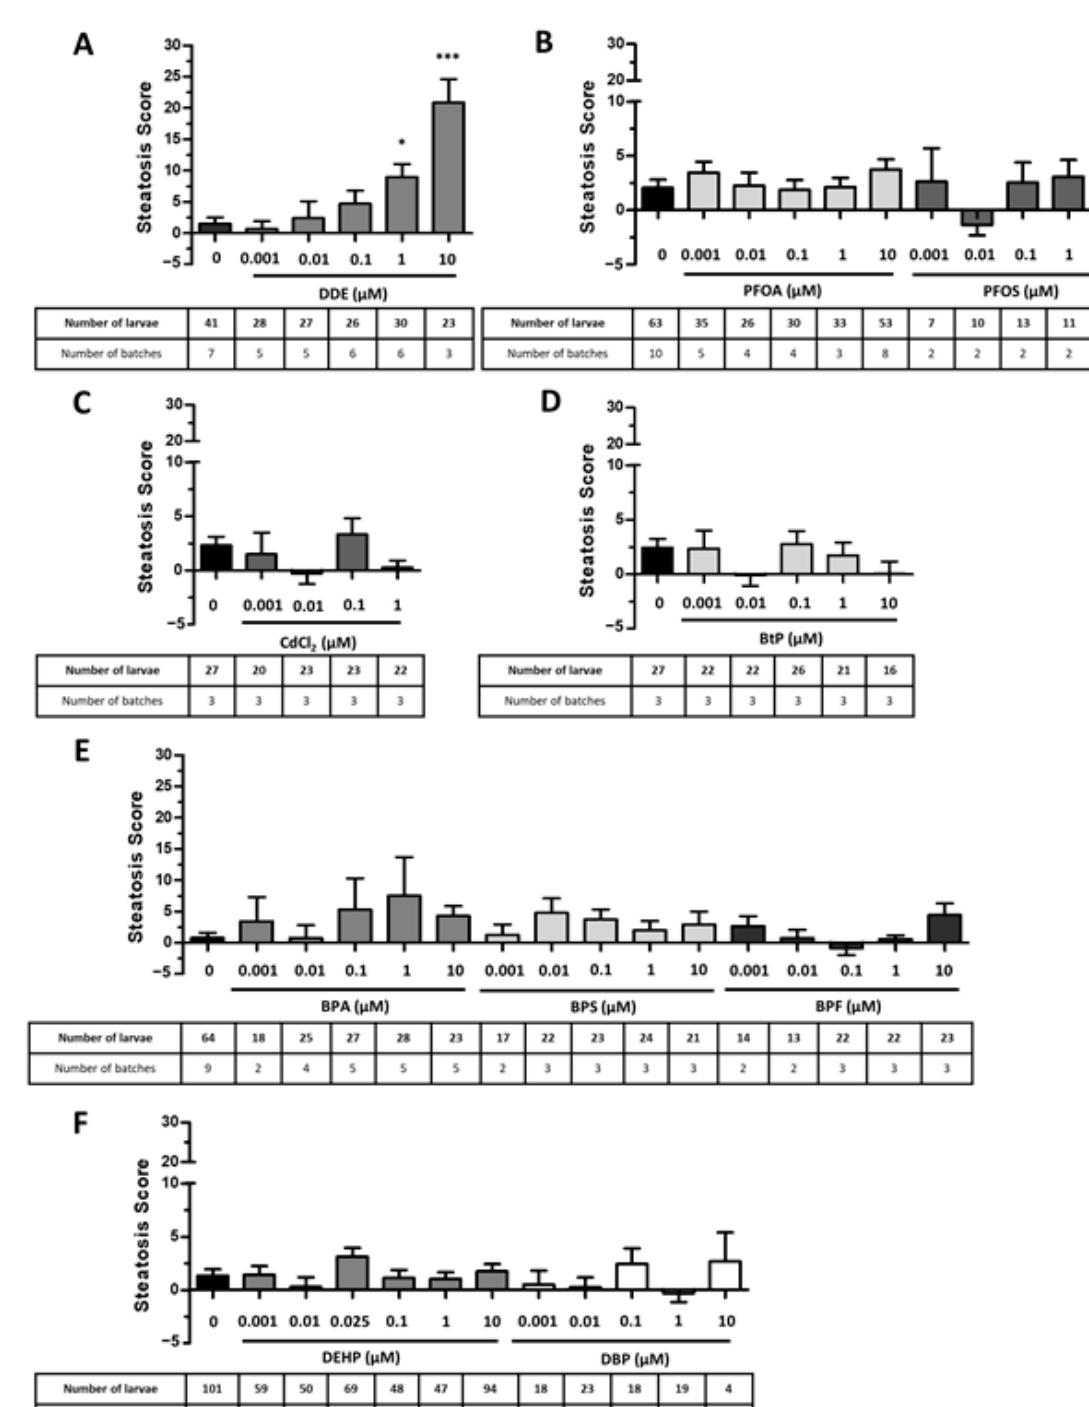
Figure 3. Screening of endocrine disruptors with the Steatogenic Assay on Zebrafish. Zebrafish larvae at 3 days post-fertilization were exposed to the selected compounds at non-toxic concentrations: DDE ( A ), perfluorinated compounds ( B ), cadmium ( C ), butyl-paraben ( D ), bisphenols ( E ), phthalates ( F ) or to vehicle alone, during 48 h. Following exposure, larvae were euthanized and fixed, and steatosis scores (based on lipid fluorescence intensity, lipid droplet density and area in the liver) were calculated based on Nile red staining and image-based automated analysis after confocal microscopy acquisition. Values are mean +/ − SEM; with the number of batches and larvae indicated in the table underneath the graph. * p < 0.05, *** p < 0.001 by comparison with control group using Kruskal–Wallis test.